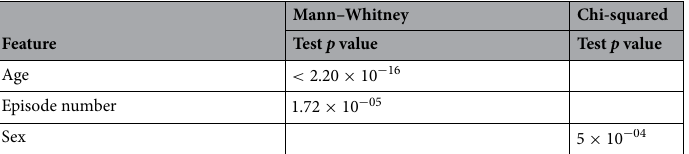
Table 4. Results of the application of univariate biostatistics tests between each feature and the survival target, in the primary cohort. Mann–Whitney test p -value: probability value generated by the application of the Mann–Whitney U test to the corresponding feature and survival. chi-squared test p -value: probability value generated by the application of the chi-squared test to sex and survival. We reported the features in alphabetical